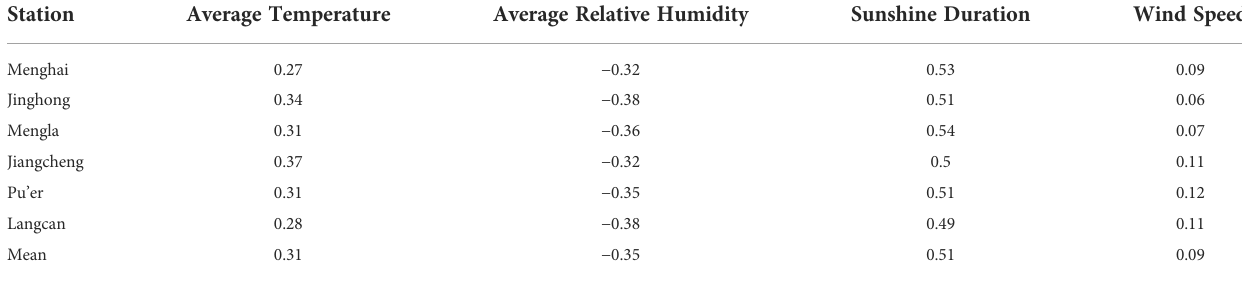
TABLE 5 Correlation coef fi cients of ET 0 and meteorological variables